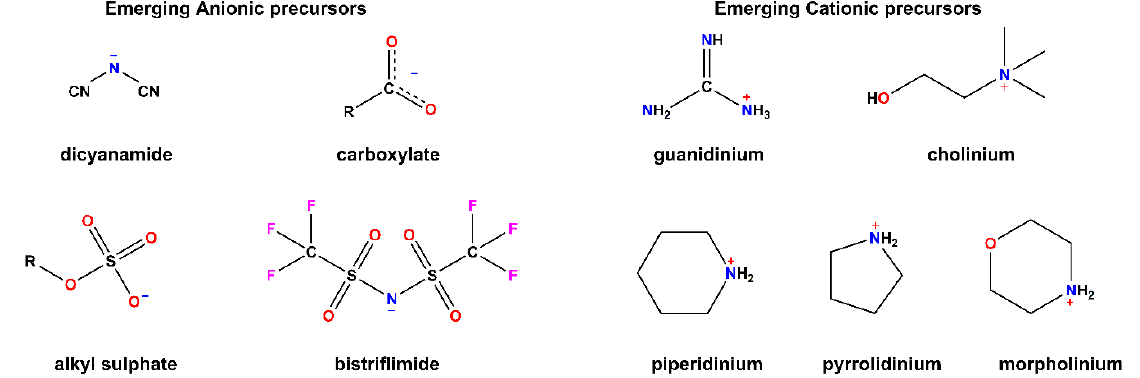
Figure 1. Emerging anions and cations used in ionic liquids (ILs).